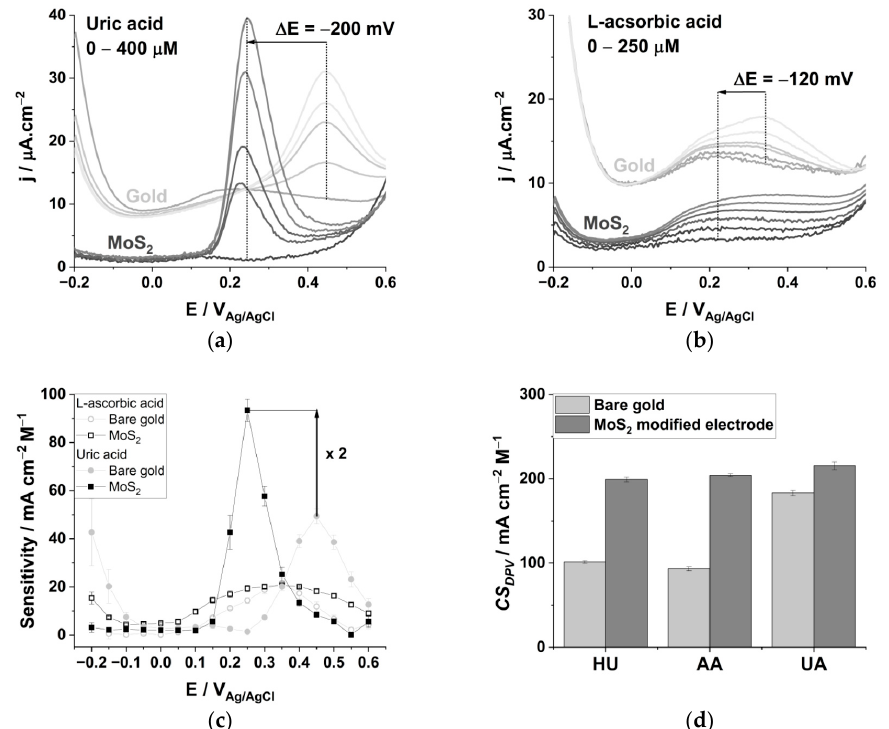
Figure 3. Differential pulse voltammograms (DPV) recorded for ( a ) uric acid and ( b ) L-ascorbic acid at the bare (grey) and the MoS 2 (black) modified electrodes. ( c ) The sensitivities over the DPV analysis potential range for uric acid (squares) and L-ascorbic acid (circles) at the Bare (grey) and the MoS 2 (black) modified electrode. ( d ) Combined selectivity of the DPV analysis ( CS DPV ) over the full potential range for hydroxyurea (HU), L-ascorbic acid (AA) and uric acid (UA). We calculated the sensitivity of each electrode toward UA and AA over the potential range of − 0.2 to 0.6 V Ag/AgCl at increasing concentrations of analytes in PBS at pH 7.4 (Figure 3c). The electrodeposited MoS 2 allows the electrochemical sensitivity to be increased to- ward UA oxidation by two-fold (from 49 ± 3 to 93 ± 5 mA cm − 2 M − 1 ), while slightly increas- ing the sensitivity toward AA at 0.4 V Ag/ACl (from 17 ± 2 to 20 ± 0 mA cm − 2 M − 1 ). It is possible to increase the sensitivity toward UA seven-fold at 0.3 V Ag/AgCl and 3.5-fold toward AA at 0.1 V Ag/AgCl with the MoS 2 modified electrode (Table S4). We calculated the cumulative se- lectivity of those DPV analyses ( CS DPV ), emphasizing that the MoS 2 -modified electrode generates twice as many features for the electrochemical determination of HU and AA (Figure 3d). The CS DPV toward AA increases from 93 ± 2 to 204 ± 1 mA cm − 2 M − 1 and from 184 ± 3 to 216 ± 5 mA cm − 2 M − 1 toward UA. The decrease of the oxidation potential for the three analytes and the two-fold increase of sensitivity for UA on the MoS 2 modified elec- trode may be explained by the relative hydrophobicity of the analytes (LogP UA < LogP HU < LogP AA < LogP H2O , see Table S5) favoring Van der Walls interactions with the electrode- posited material [51]. The sensitivity and limit of detection for HU is comparable to other MoS 2 modified electrodes present in the scientific literature, and the sensitivity and limit of detection toward UA and AA falls in the same range as previously published results for different electrode materials (Table S6). 3.3. Analysis of Hydroxyurea in a Simulated Serum Using Chemometrics